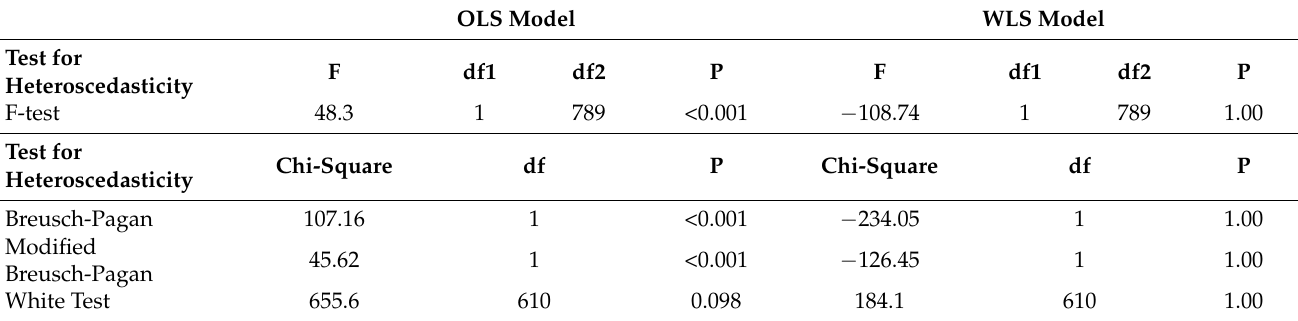
Table 2. Tests of Heteroscedasticity for OLS and WLS models of car ownership in